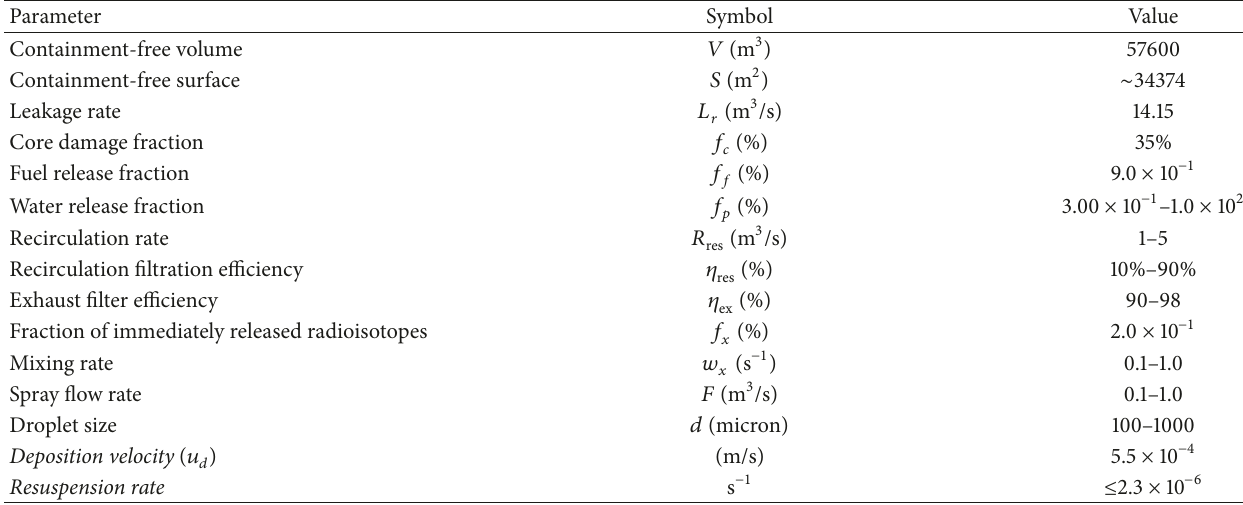
Table 3: Important parameters used for simulation [35].